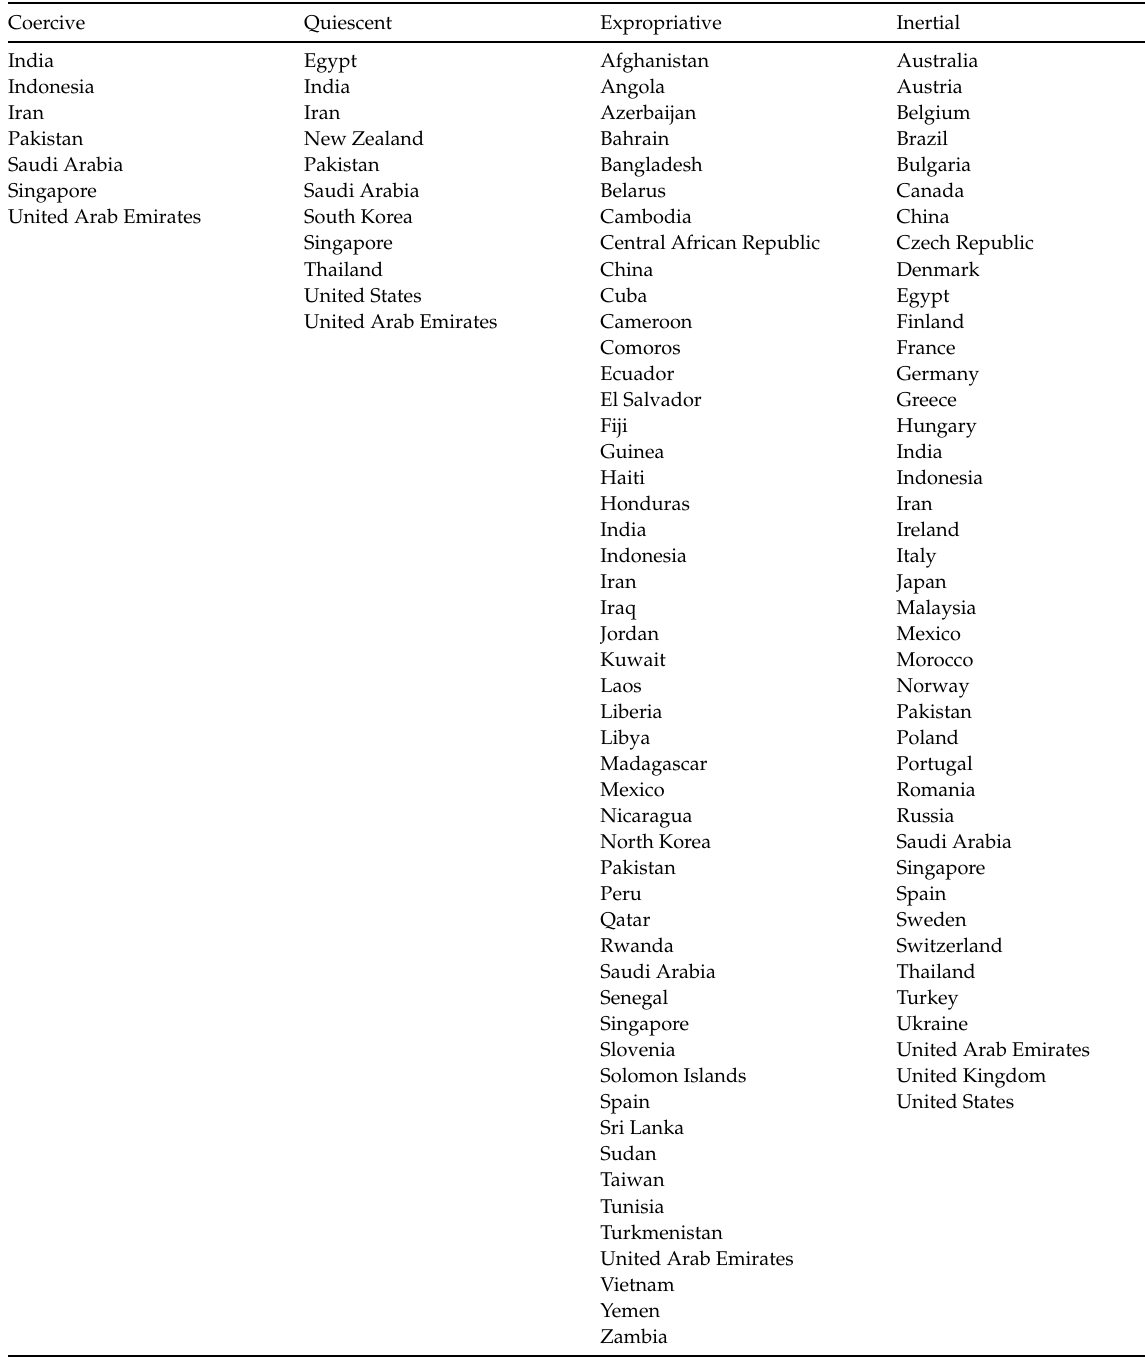
Table 9: Configurations and polluter profiles by